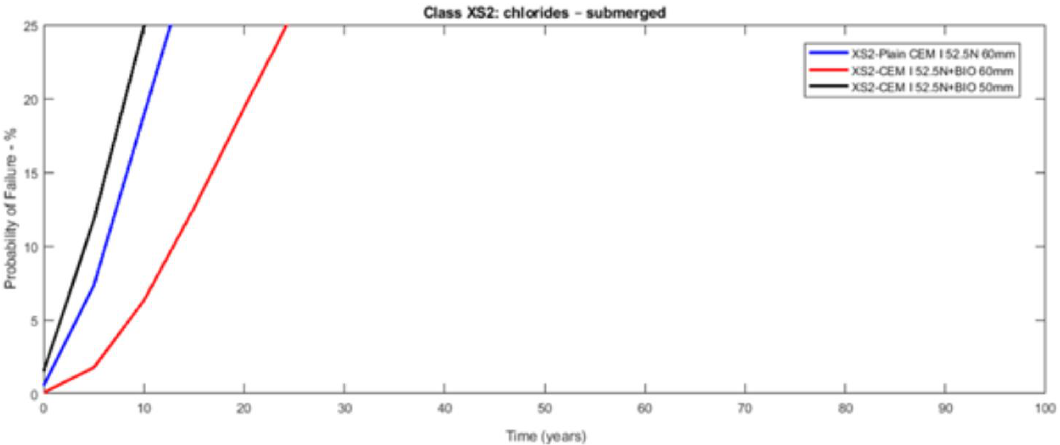
Figure 5. Probabilistic service life results of CEM I 52.5N concrete—exposure class XS2 (submerged)—without and with bioproduct for a cover of 60 and 50